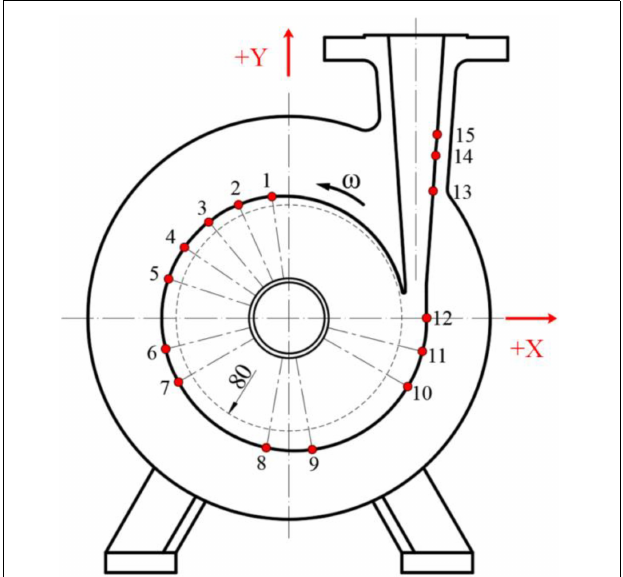
FIGURE 5 | Installation position of the pressure sensor.